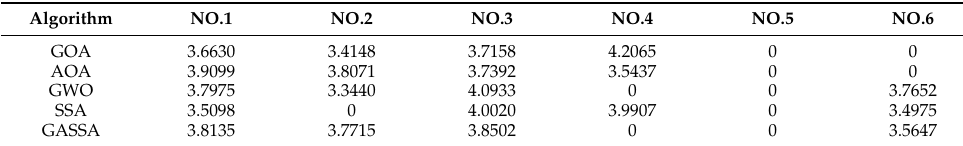
Table 7. Optimal load-sharing scheme.